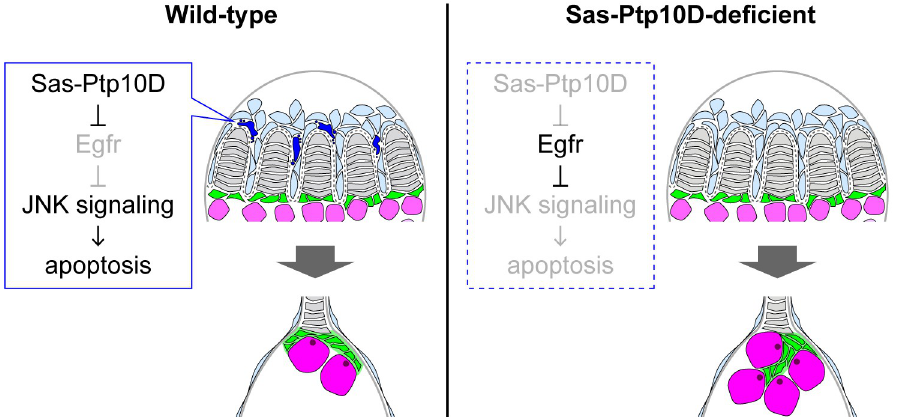
Fig 7. Hypothesis for the role of Sas-Ptp10D in controlling the GSCs via shaping GSC-niche. In the gonadogenesis at pre-pupal stage (left), apoptosis is stochastically emerged in apical cells neighboring terminal filament cells. The Sas- Ptp10D-mediated apopotosis of apical cells ensure shaping the dish-like structure of cap cell-cluster which restrict the number of GSCs to 2 or 3. Sas-Ptp10D has roles to facilitate apoptosis by downregulation of the Egfr signaling, which suppressed the activation of the JNK signaling. In Sas-Ptp10D-deficient state (right), hyperactivation of the Egfr signaling suppressed the JNK signaling-inducible apoptosis. Suppression of apoptosis caused disruption of appropriate shaping of cap cell-cluster, thereby the residential space (niche) of GSCs is expanded to increase the number of GSCs.